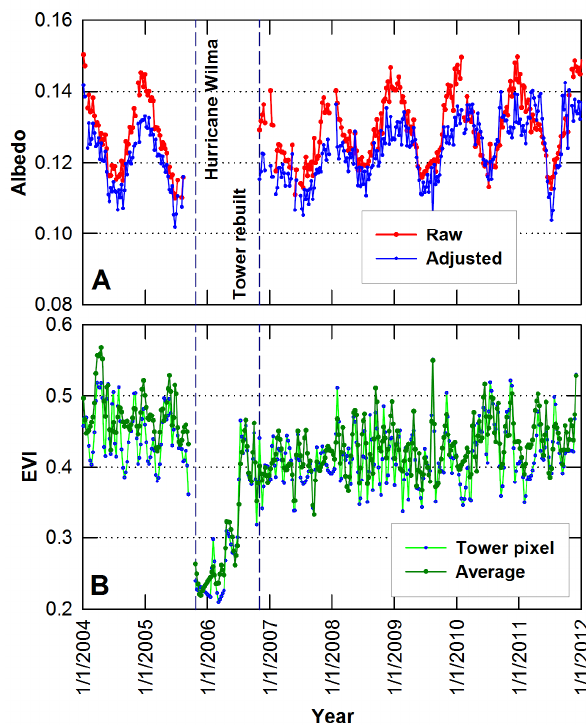
Fig. 3. Eight-day average albedo (raw) and albedo adjusted to include only those values when the solar elevation angle was between 35 o and 50 o ( A ). Eight-day 500-m resolution EVI ( B ) values were linearly interpolated using 16-day composites. Averages include the pixel that contains the tower site and the adjacent 8 pixels.